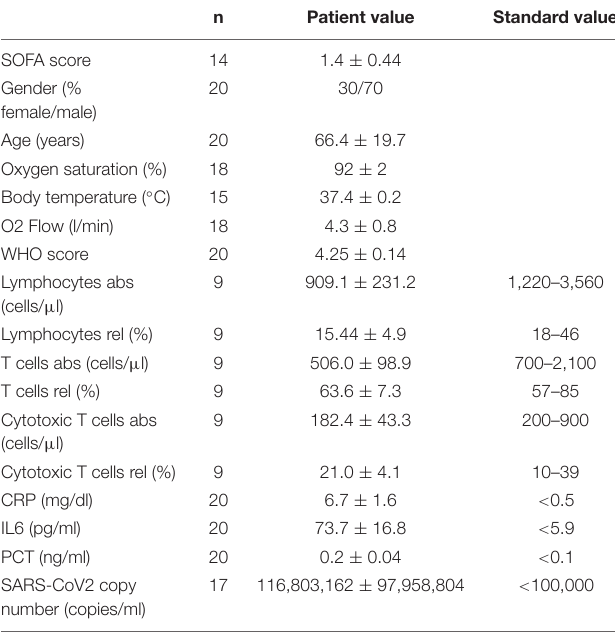
TABLE 1 | Patient